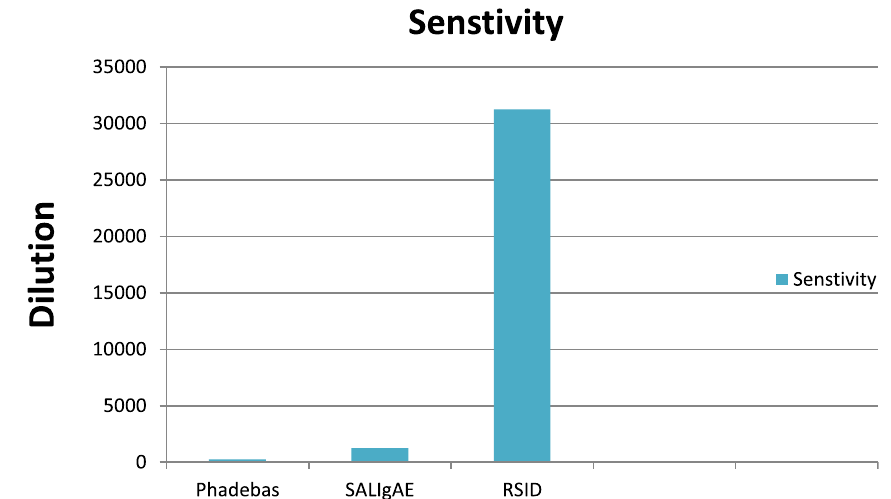
Fig. 1 Sensitivity comparison of Phadebas, SALIgAE, and RSID